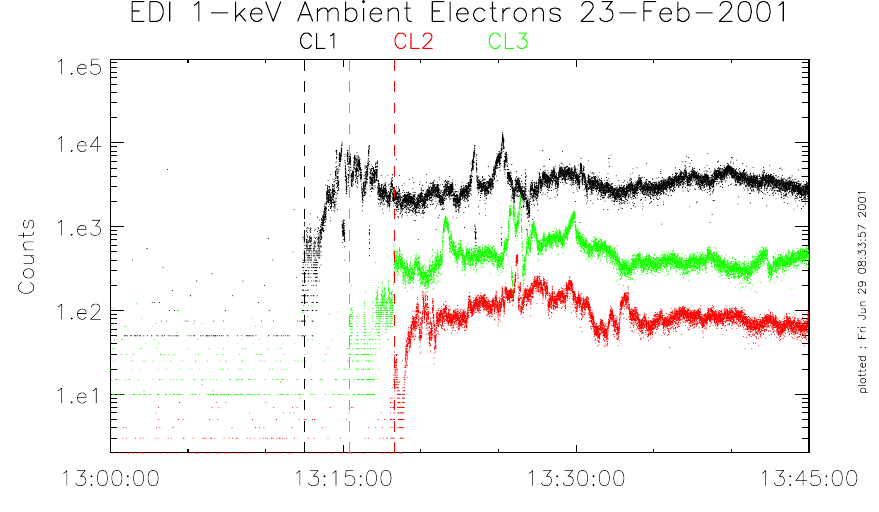
Fig. 7. EDI 1keV, 90 ◦ pitch-angle am- bient electron counts for spacecraft 1, 2, and 3, using the same colors as in the other figures. Counts for space- craft 1 and 3 are offset by factors of 25 and 5, respectively. Count levels of 0 and 1 are clipped. Fiducial marks at the strong count intensifications seen by each spacecraft are plotted at 13:12:30, 13:15:25 and